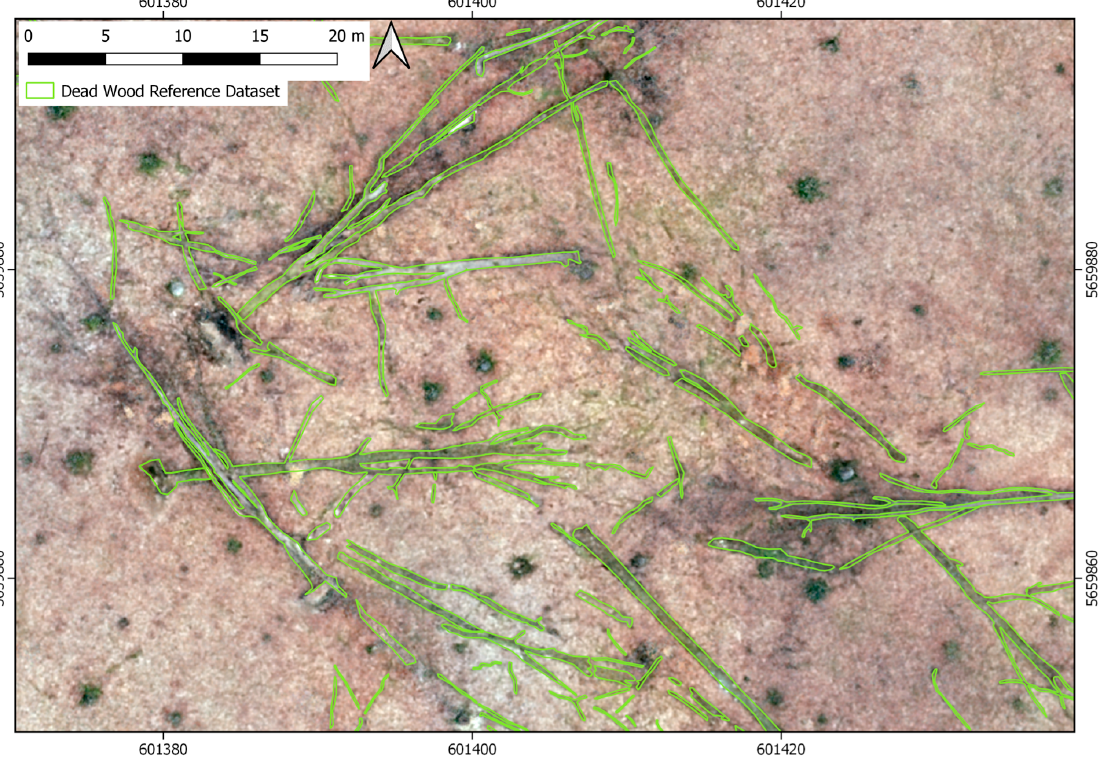
Figure 6. Subset of the reference data used for validation. Since no suitable in-situ dead wood measurements were available, the dead wood was digitized manually for a quarter of the Huss site. A total of 225 dead wood objects met the criteria of the HNP administration.